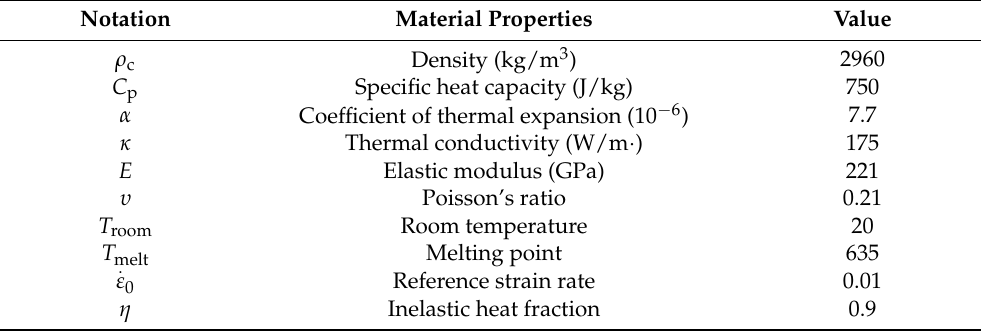
Table 4. Physical and mechanical properties of Al6063/SiC p /65p composites